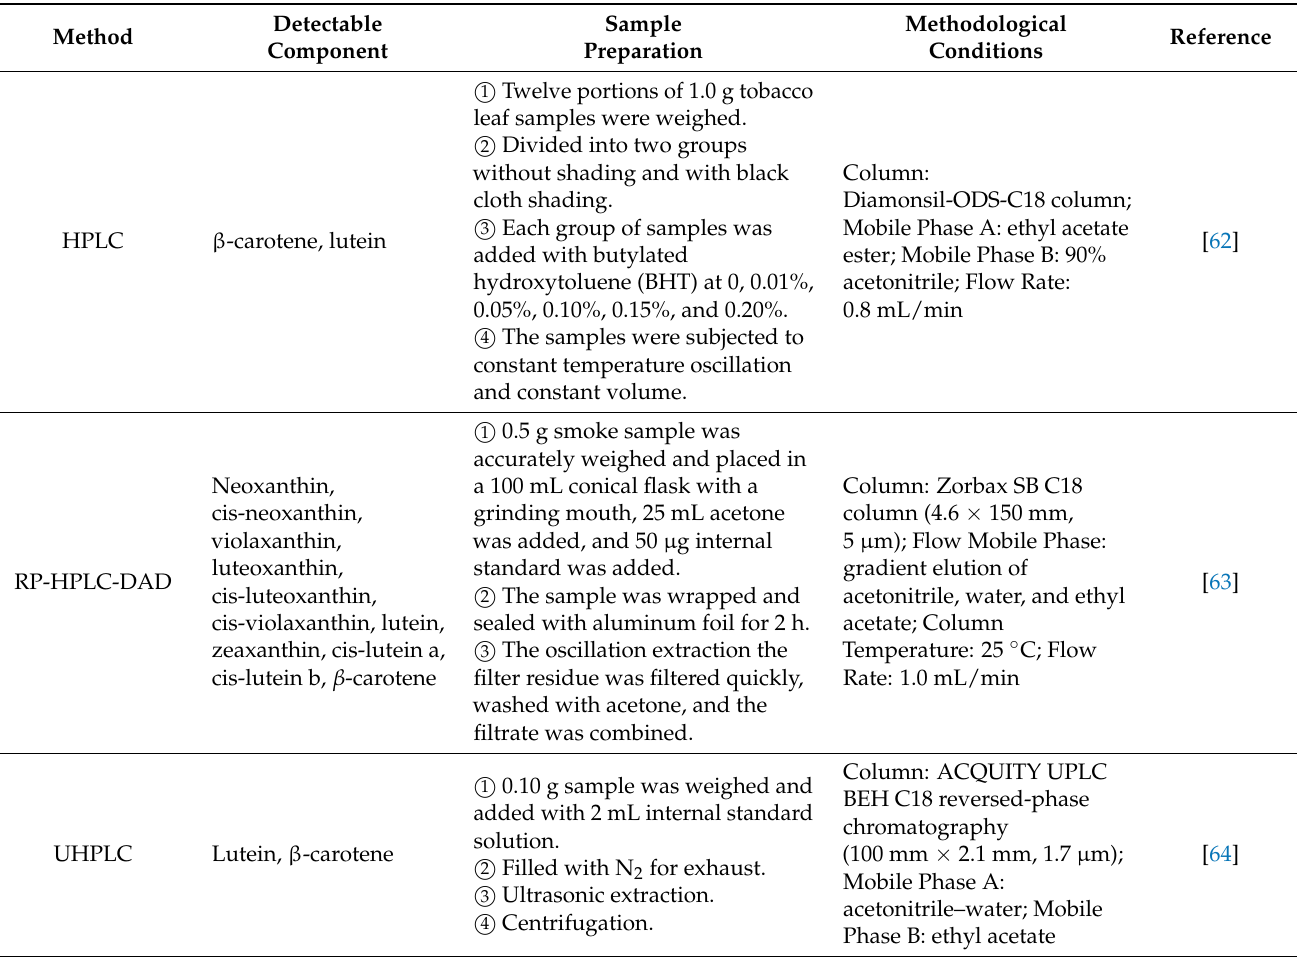
Table 2. Methods for determining carotenoid in tobacco